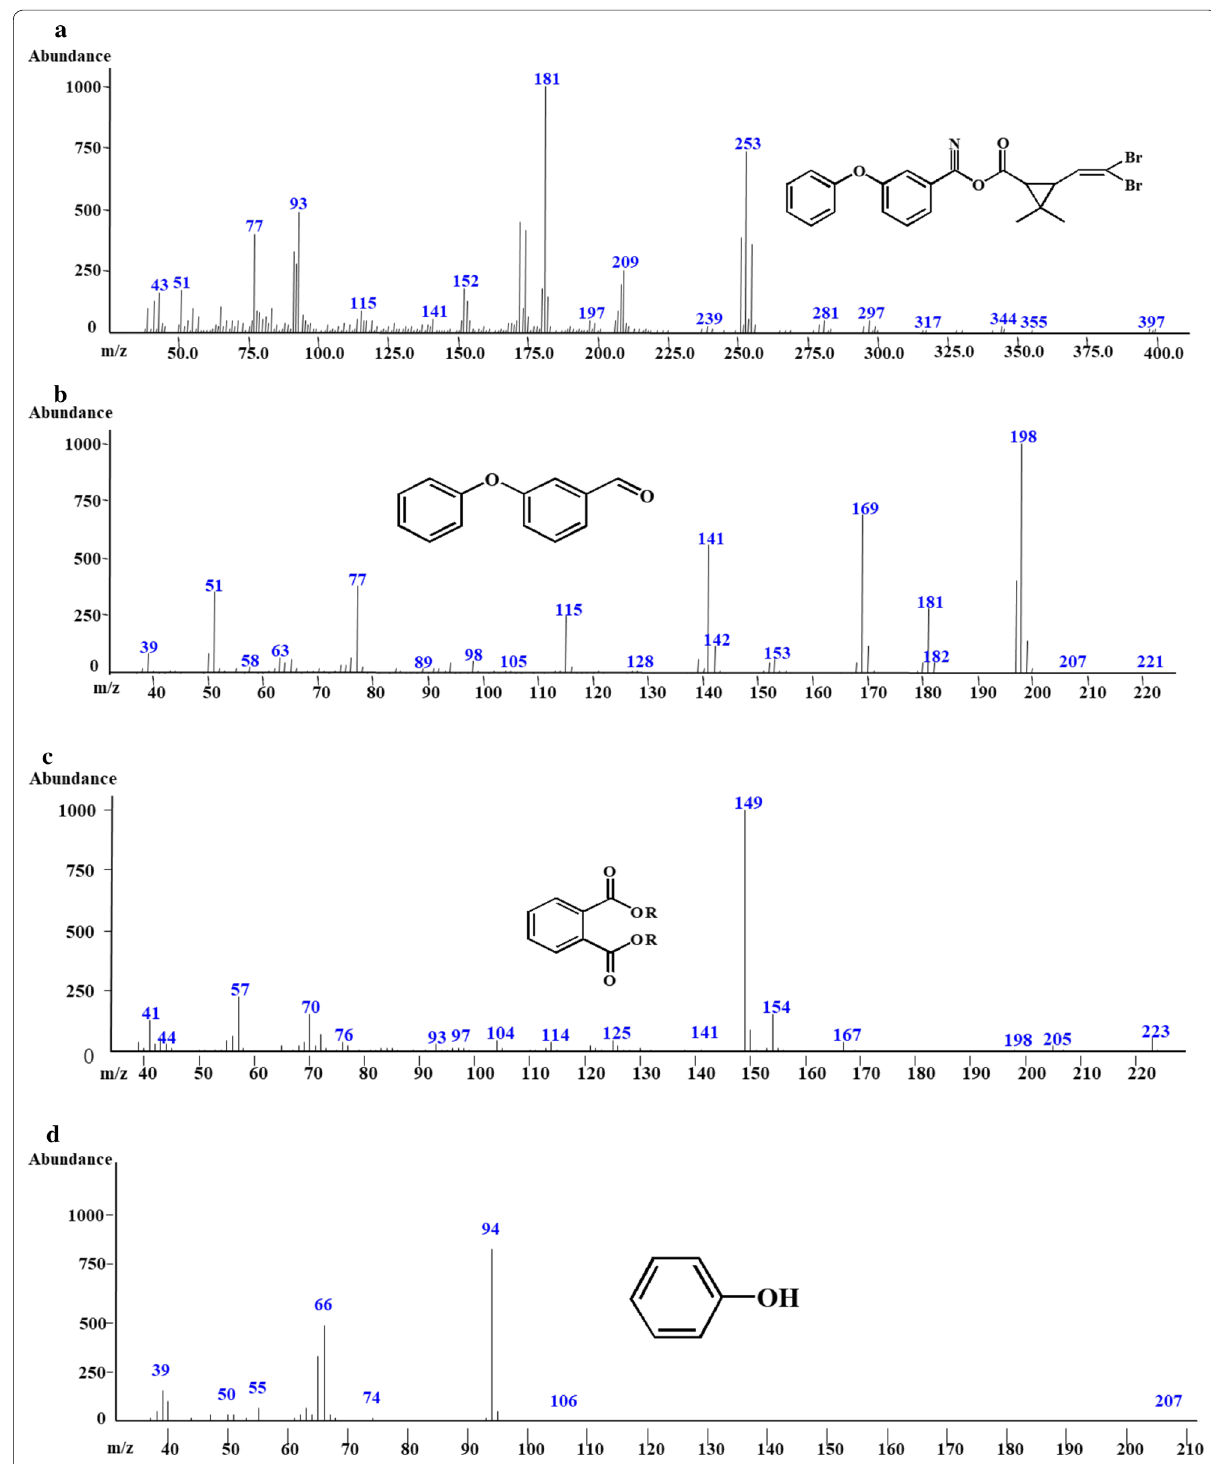
Fig. 5 a – c m/z of compounds (A-C) in GC–MS from deltamethrin degradation by strain LH-1-1. b – d m/z of compounds (B-D) in GC–MS from deltamethrin degradation by co-culture of strains LH-1-1 and